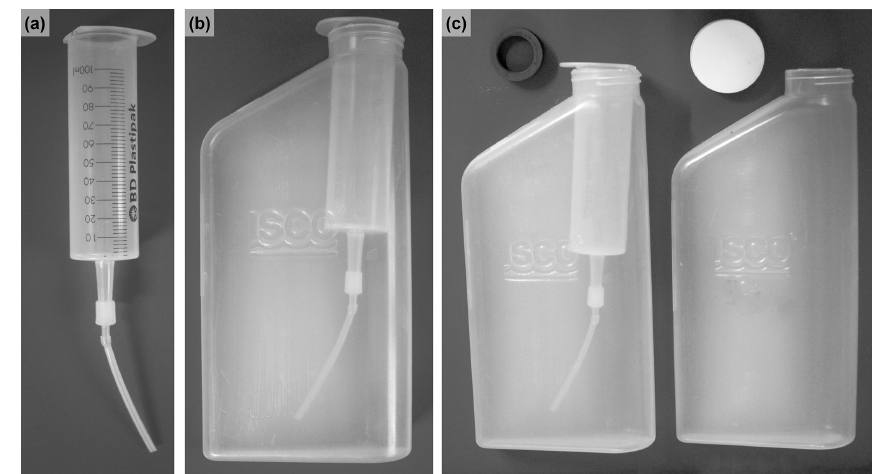
Figure 1. (a) Modified 100mL syringe housing with Luer-tip adapter and fitted silicone tubing for extending the syringe outlet towards the bottom of the bottle; the barrel flange at the syringe housing was trimmed on the outer side to ensure the retrofitted bottles fit into the autosampler. (b) Retrofitted sample bottles with evaporation protection using the modified syringe shown in (a) . (c) The sample bottles with evaporation protection can be sealed for transport with black rubber piston stoppers (left); bottles without evaporation protection can be sealed with a screw lid